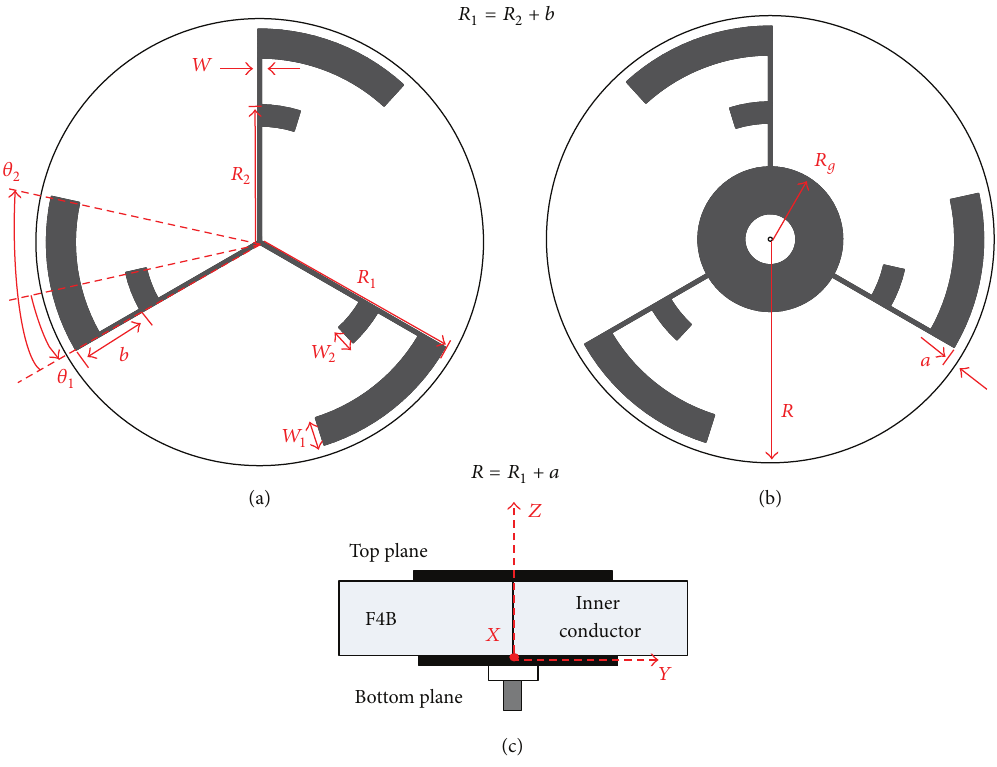
Figure 1: The structure of the microwave antenna: (a) top plane, (b) bottom plane, and (c) side view.